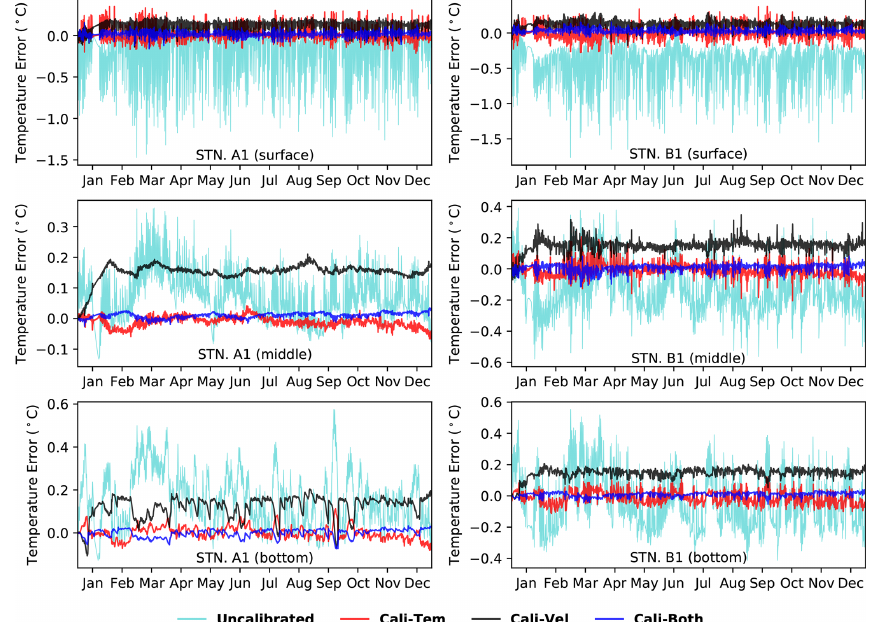
( X ∗ ) and observed water temper- t,j